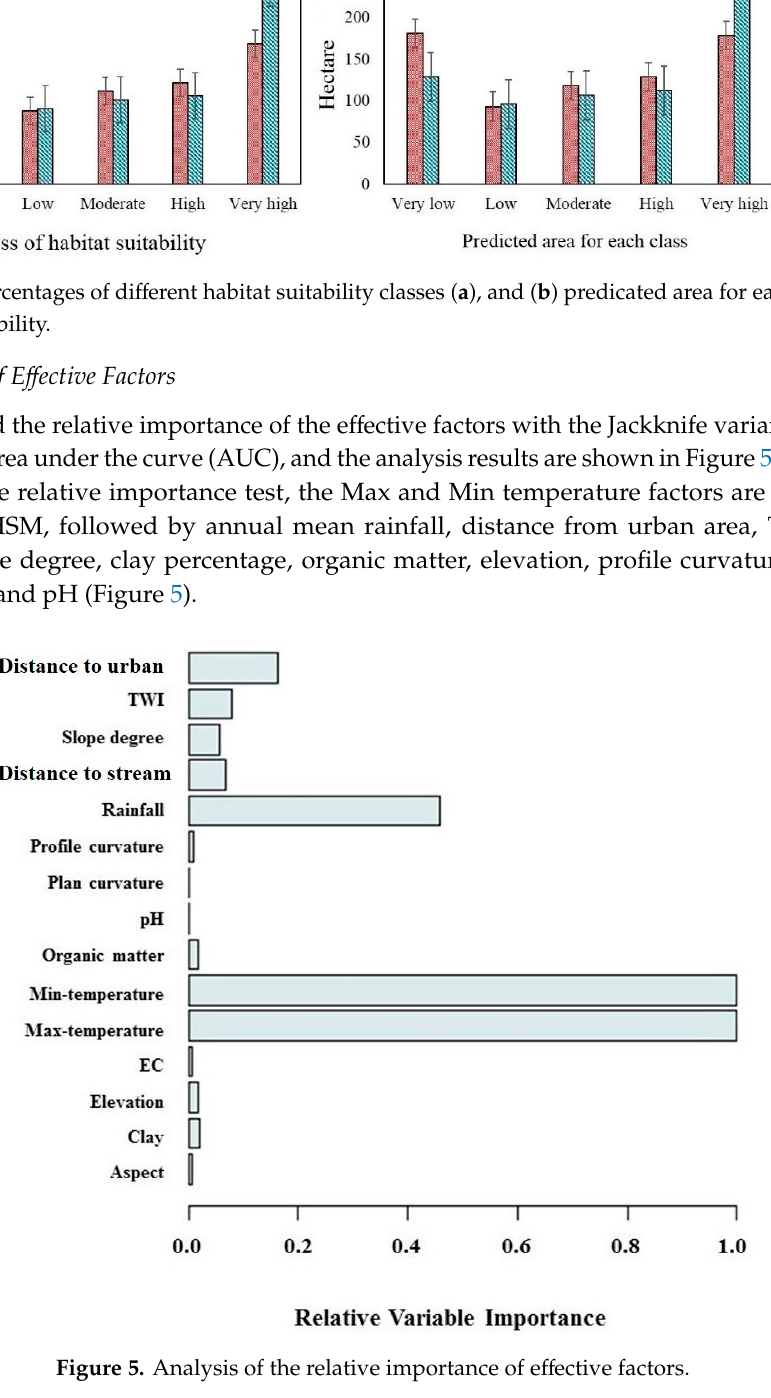
Figure 3. Habitat suitability maps using: ( A ) maximum Entropy (MaxEnt), and ( B ) support vector machines (SVM) models.